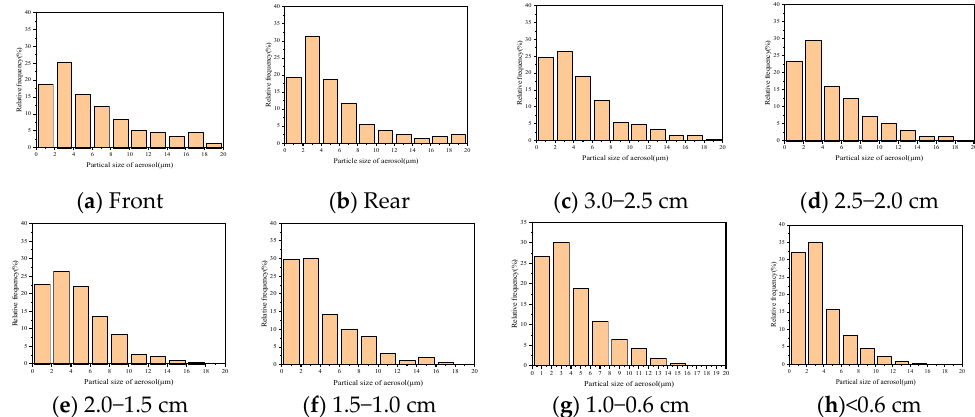
Figure 11. Aerosol particle size distribution under different void structures. ( a ) is the droplet at the entrance of the empty pipe; ( b ) is the droplet at the exit of the empty pipe; ( c ) is the exit droplet with a particle size of 3.0 − 2.5 cm; ( d ) is the exit droplet with a particle size of 2.5 − 2.0 cm; ( e ) is the exit droplet with a particle size of 2.0 − 1.5 cm; ( f ) is the exit droplet with a particle size of 1.5 − 1.0 cm; ( g ) is the exit droplet with a particle size of 1.0 − 0.6 cm; and ( h ) is the exit droplet with a particle size of <0.6 cm.